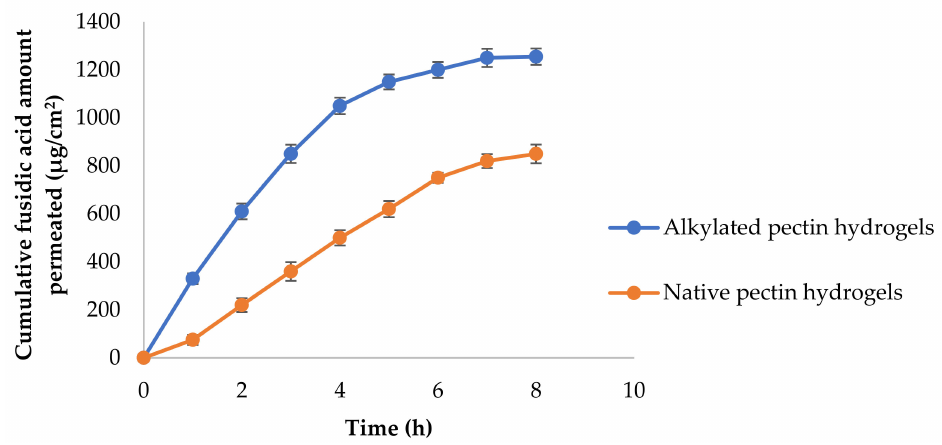
Figure 9. Fusidic acid permeation through Strat-M ® membrane ( n = 3; ±